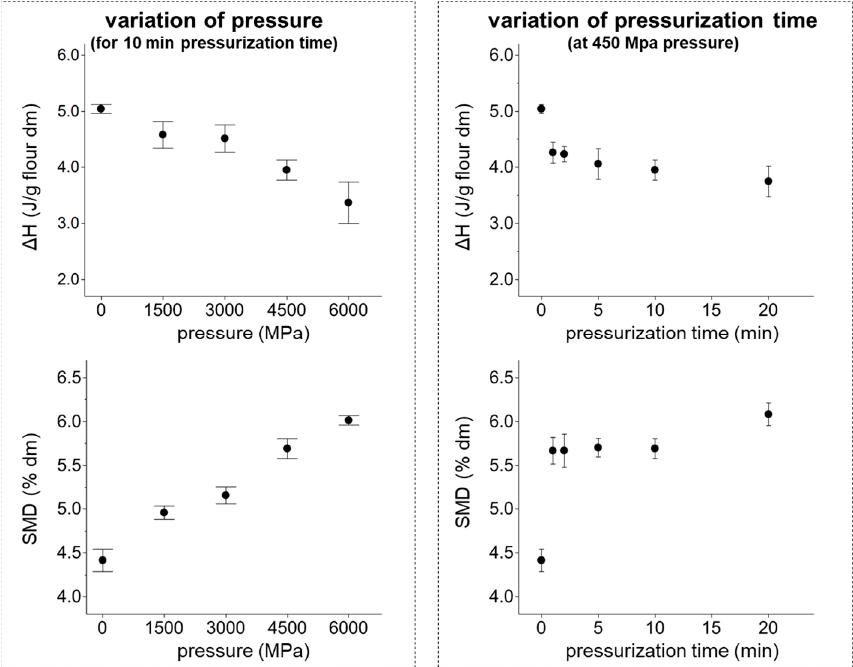
Figure 1. Impact of pressure and pressurization time on the gelatinization enthalpy ( Δ H) and starch modification degree (SMD) of wheat flour, (cid:1876)̅ ± SD, n = 3